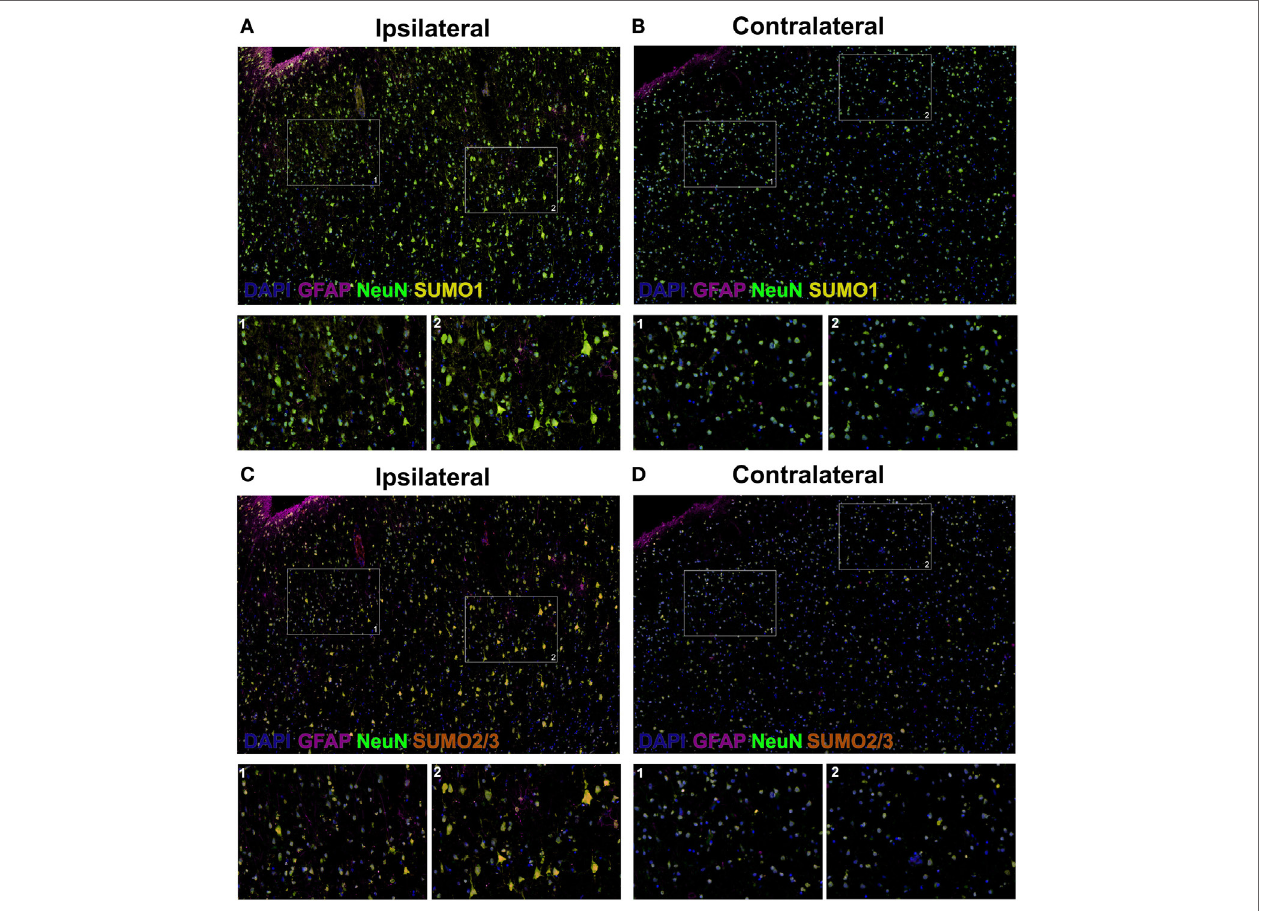
FIGURe 3 | High-resolution composite fluorescent multiplex immunohistochemistry (mIHC) images (yellow, SUMO1; red, SUMO2/3; blue, DAPI; green, NeuN; violet, GFAP). (a) Ipsilateral, SUMO1. (B) Contralateral, SUMO1. (C) Ipsilateral, SUMO2/3. (D) Contralateral, SUMO2/3. Capture parameters of ipsilateral and contralateral images were identical. Cropped ROIs were taken from comparable layers of cortex. The intensity of SUMO1 and SUMO2/3 immunoreactivity is increased in neurons residing within the penumbral tissue compared to neurons in the matched contralateral anatomy; in addition, SUMO1 and SUMO2/3 immunoreactivity is translated from the cytoplasm to the nucleus in penumbral neuronal